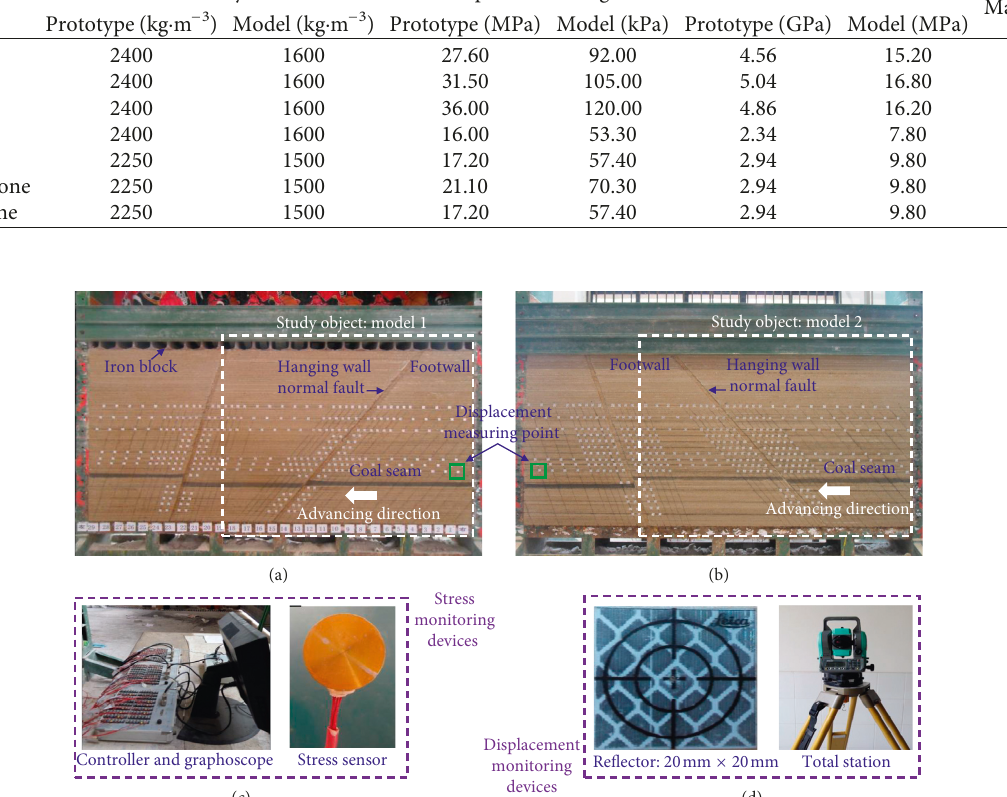
Figure 2: Overview of Model 1 (a) and Model 2 (b). Stress monitoring device (c). Displacement monitoring device